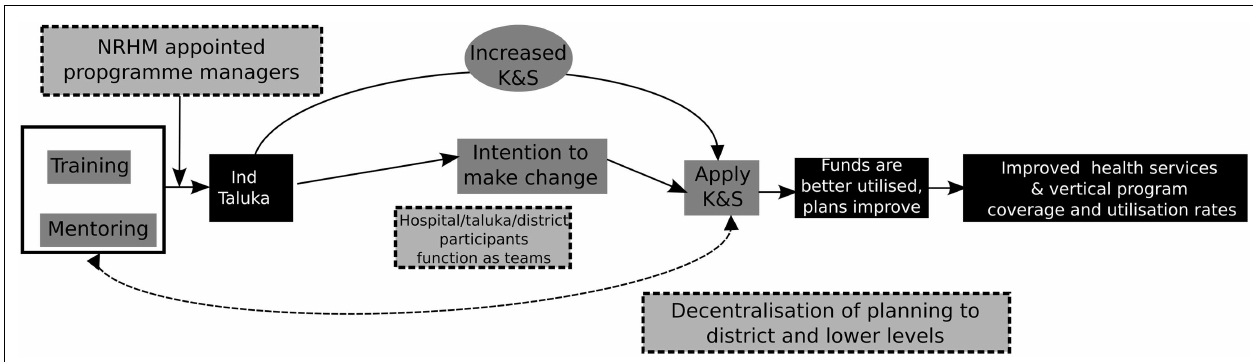
health note that the role of context in producing desirable out- comes in HRM interventions is under-explored; either contextual factors are neglected in designing effectiveness evaluations,or con- text descriptions are scarce, rendering the studies not amenable to realist reviews (7,